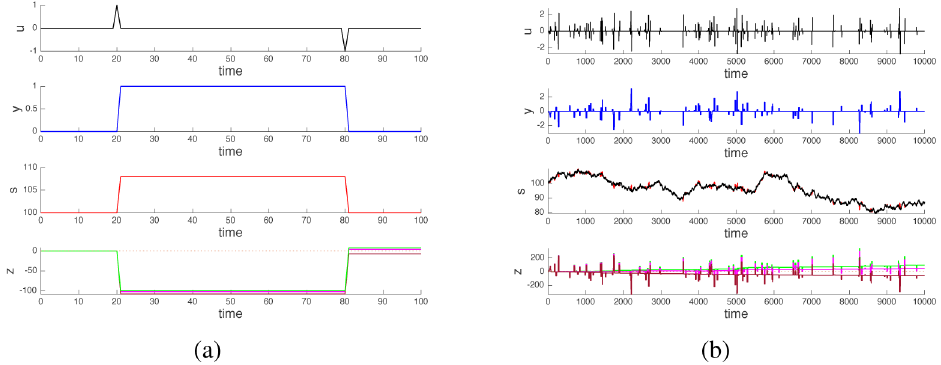
Fig 6. Spread reduces profits (or induces losses). Panel (a): In Eq (12), the presence of a quote spread decreases the value of z ( t end ) − z (0) i.e., the geometric phase at the end of a cycle. In the plot for z , if the green curve corresponds to q = c = 0, the magenta and brown curves correspond to different choices of these parameters. Depending on the values of r , q and c , the geometric phase can correspond to a profit (green and magenta curves, z ( t end ) > z (0)), or to a loss (brown, z ( t end ) < z (0)). Panel (b): The geometric phase (and the corresponding profits or losses) accumulates over repeated trading cycles. For short trading cycles the presence of a stock drift { w ( t i )} does not alter the result, i.e., what happens in a single cycle (panel (a)) to the cash balance z ( t ) happens also when many cycles are performed in presence of stock drift { w ( t i )} (panel